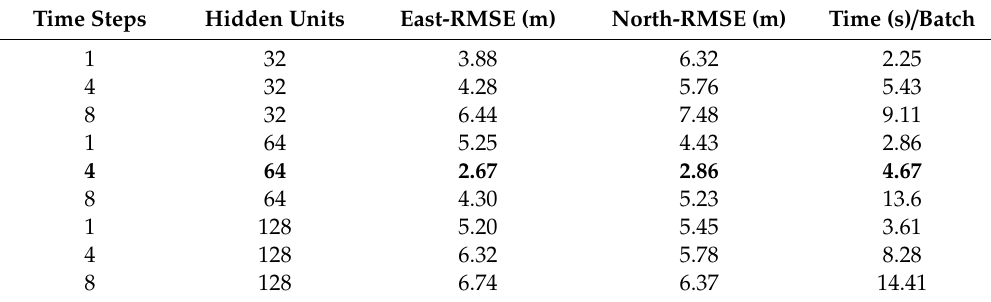
Table 3. Root mean square error (RMSE) with di ff erent time steps and hidden units.